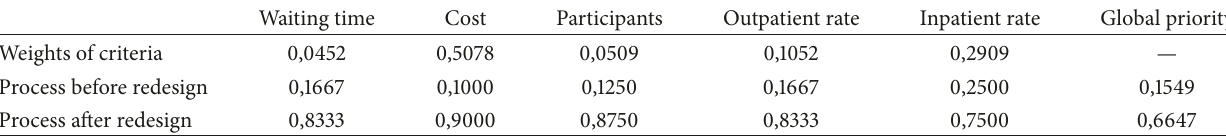
Table 5: AHP: global priority of both versions of the care